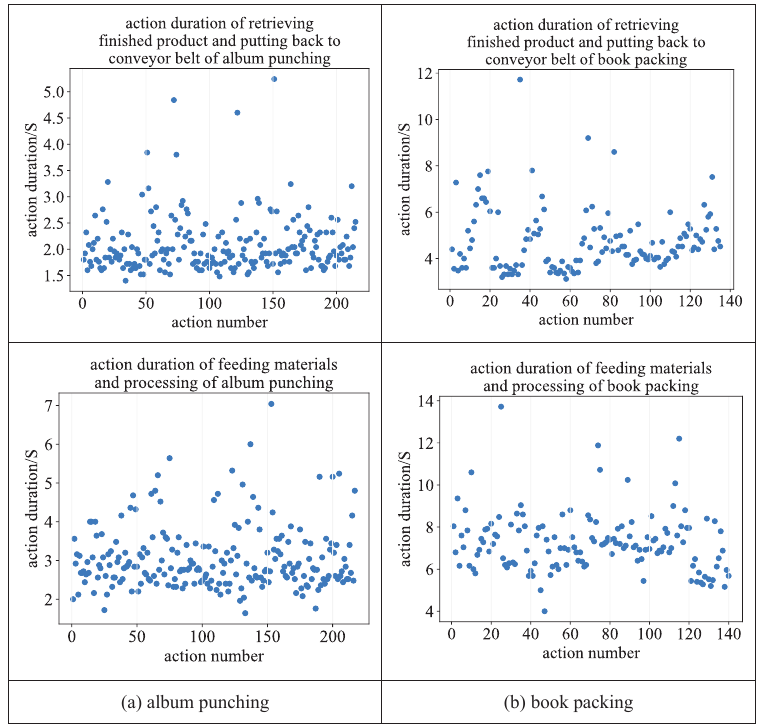
Figure 4. Scatter plots of action